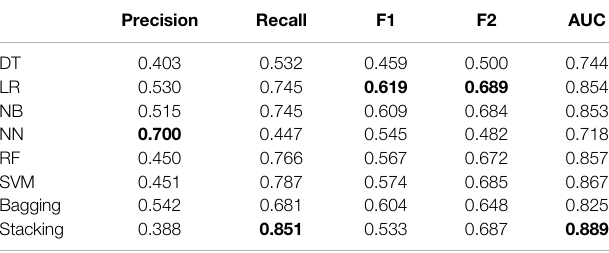
TABLE5| Dietarybiomarkersclassi fi ersonthetestset.Precision,recall,F2-score and AUC achieved each algorithm: Decision Tree (DT), Logistic Regression (LR), Naïve Bayes (NB), Neural Network (NN), Random Forest (RF) and Support VectorMachine(SVM),aswellastheBaggingandStackingapproaches,usingthe combinations that achieved the highest